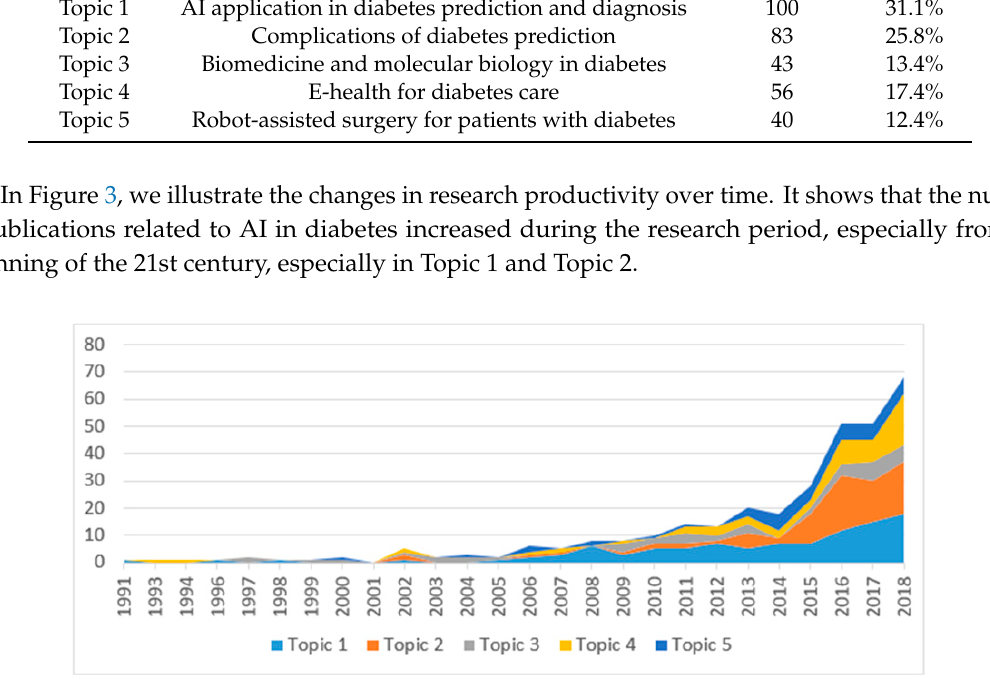
Figure 3. Changes in applications of Artificial Intelligence to diabetes research during 1991-2018.